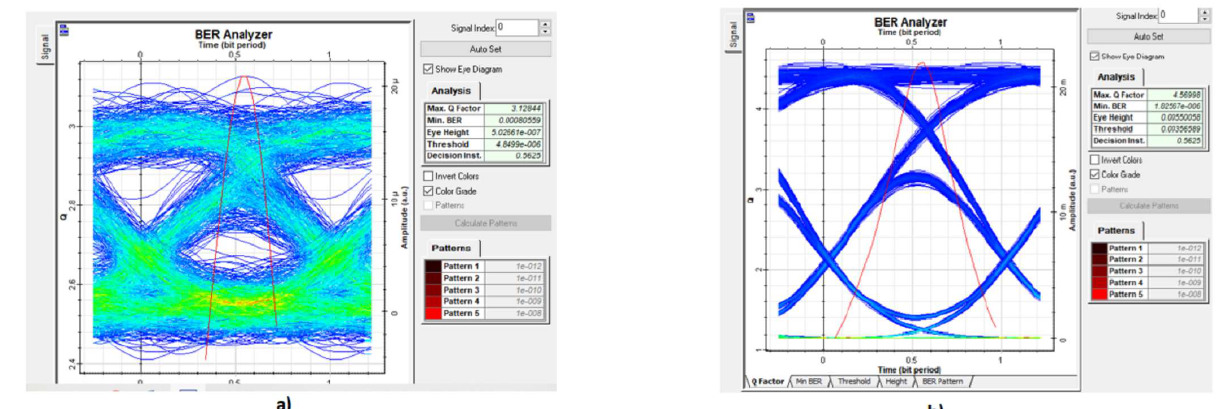
Figure 6. Result of WDM analysis with 4 channels BER simulation results: a) Eye diagram without EDFA and b) Eye diagram